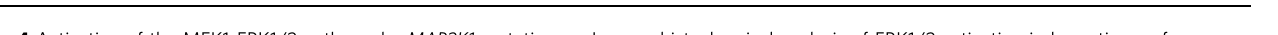
Fig. 4 Activation of the MEK1-ERK1/2 pathway by MAP2K1 mutations. a Immunohistochemical analysis of ERK1/2 activation in bone tissues from a melorheostosis patient. Left column shows sections of colon cancer stained with p-ERK1/2-speci fi c antibodies. Marked brown staining is visible. Middle column shows a section of normal bone stained in a similar fashion. Right column shows representative section from melorheostotic bone (Melo-18, MAP2K1 p.K57N, VAF 46%) stained with p-ERK1/2-speci fi c antibodies. Osteocytes stain brown surrounded by woven bone. Cells positive for p-ERK1/2 are also seen in the periosteum. Inset shows high-power view of positively staining cells. A multinucleated osteoclast which does not stain for p-ERK1/2 is marked by the solid arrow. Cells negative for p-ERK1/2 are noted by the open arrows. See Supplementary Figure 3 for staining of SW48 colon cancer cells, which harbor the MAP2K1 p.K56P mutation. b p-ERK1/2-speci fi c fl ow cytometry analysis. Affected and unaffected osteoblasts from Melo-2 ( MAP2K1 p. K57N, VAF 45%) were stimulated with serum with or without MEK inhibitor U0126. Two peaks in the histogram indicates cell subpopulations of distinct level of p-ERK1/2 upon serum-stimulation in osteoblasts from affected bone (red), cells from unaffected bone (blue) only showed a single peak. U0126 reduced p-ERK1/2 in cells from affected bone. Cells stained with matching rabbit IgG isotype control are also shown (gray). The geometrical mean channel fl uorescence is shown below for the high and low peaks of p-ERK1/2 marked on the histograms. c Western blot analysis of osteoblasts from affected and unaffected bone of patient Melo-2 ( MAP2K1 p.K57N, VAF 45%) shows increased ERK1/2 activation (p-ERK1/2) by MEK1 mutation in affected osteoblasts (lane 7 of p-ERK1/2 blot), as compared to unaffected osteoblasts (lane 3), by serum-stimulation. Inhibition of MEK1 with U0126 signi fi cantly diminished p- ERK1/2 in both affected and unaffected, but the level of p-ERK1/2 was still higher in affected osteoblasts compared to unaffected (lanes 4 and 8). Quanti fi cation data of band intensities are shown in a table. COX IV was used as control for equal amount protein